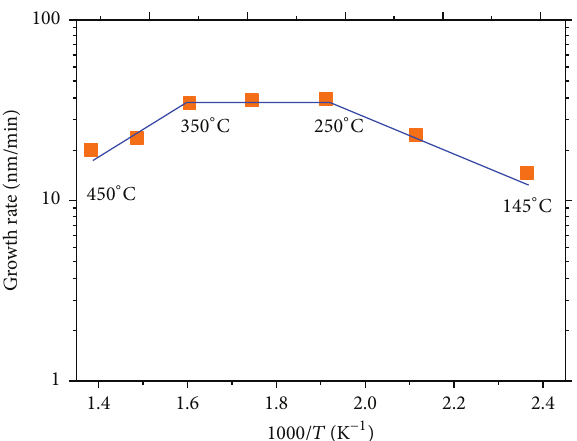
Figure 2: Arrhenius plot of the film growth rate of GZO film against the reciprocal of the absolute